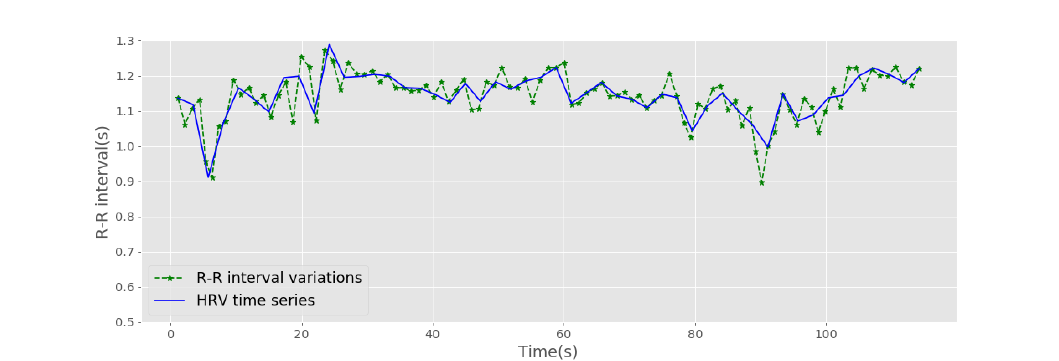
Figure 7. Heart Rate Variability (HRV) time series.